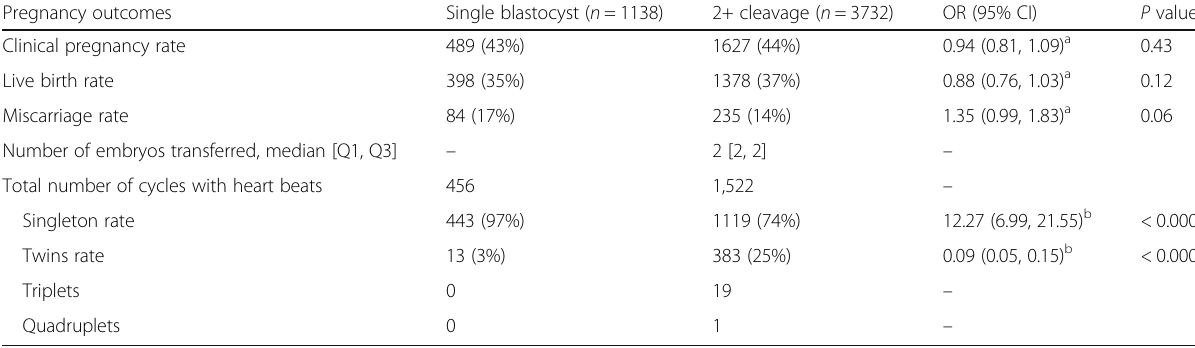
Table 3 Pregnancy outcomes by single blastocyst and 2+ cleavage Pregnancy